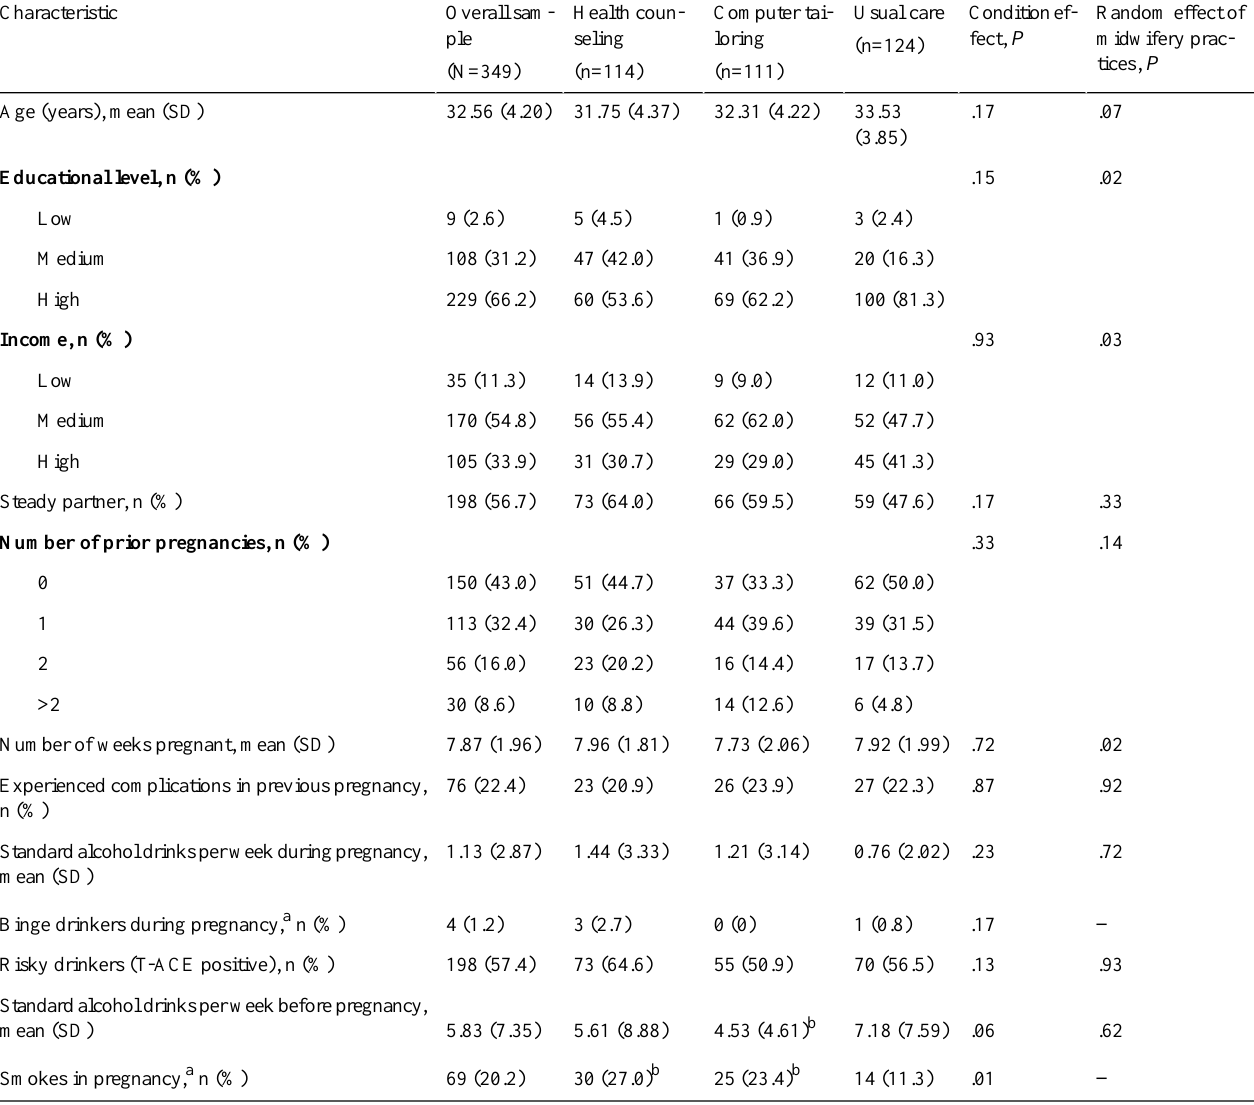
a Single-level analyses were conducted on the characteristics binge drinking and smoking during pregnancy because in the multilevel analyses, the estimates of the variances of the random effects were 0 and the Hessian matrices were not positive definite. b Indicates significant difference compared to usual